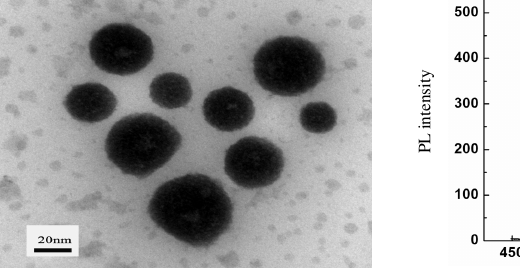
Wavelength, Figure 1. TEM images of CdTe Figure 2. The normalized luminescence spectra of CdTe QDs before (solid line) and after conjugation with dendrimer (dash line)